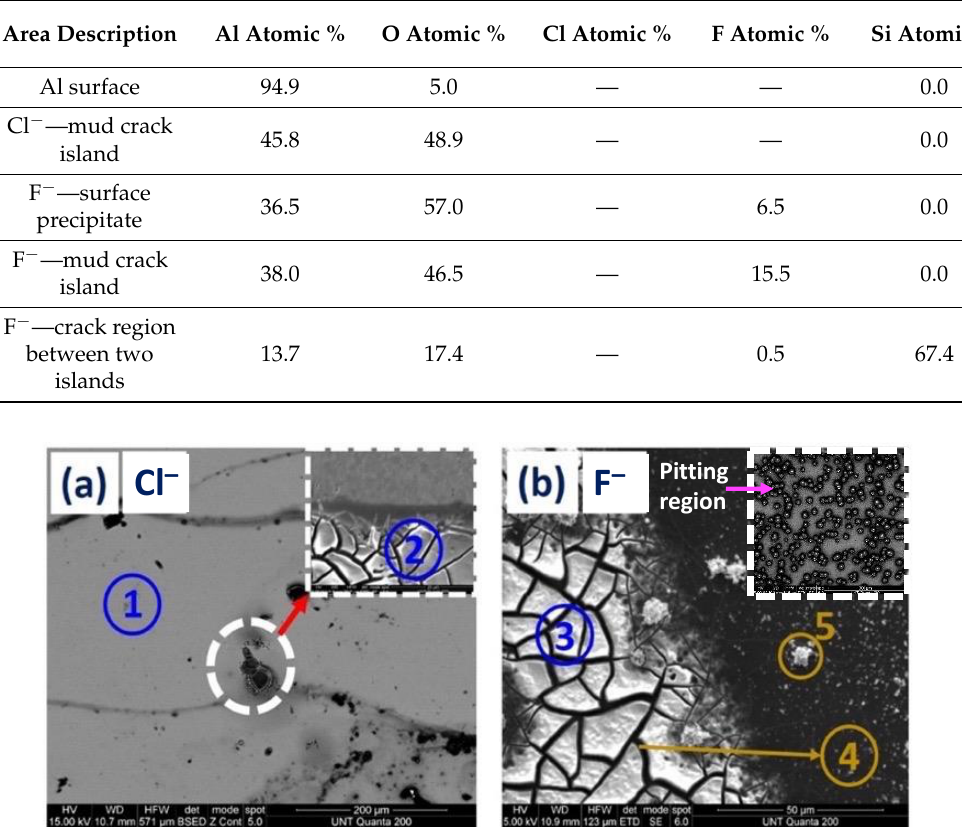
Table 1. EDS data for spots numbered in the SEM images in Figure 3. Figure 2. Corrosion screening of blanket Al samples. ( a ) As prepared before immersion. ( b ) Im-